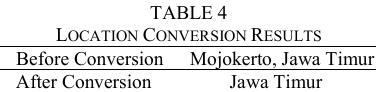
TABLE 4 L OCATION C ONVERSION R